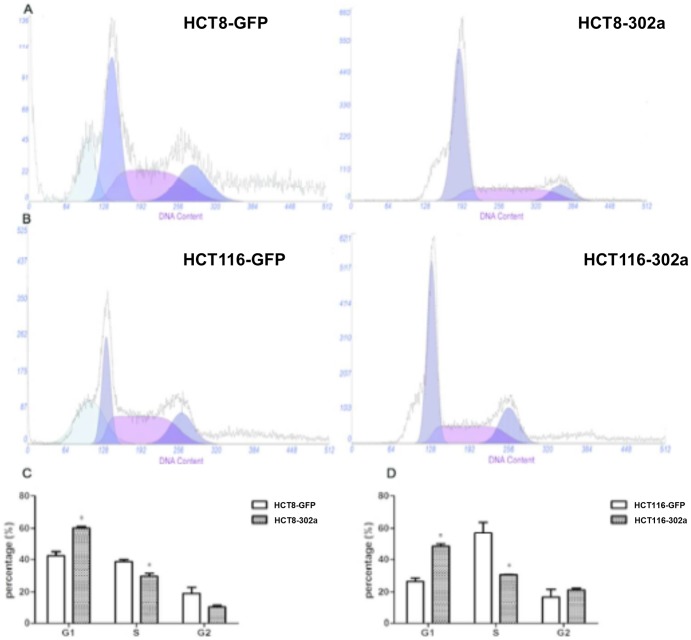
Overexpression of miRNA-302a induces G1/S phase cell cycle arrest in colon cancer cells.The proportion of cells in G1-phase increased significantly in HCT8-302a cells (A, C) and HCT116-302a cells (B, D) compared with controls, while the proportion of cells in the S phase were notably less than the controls. (* P<0.05).